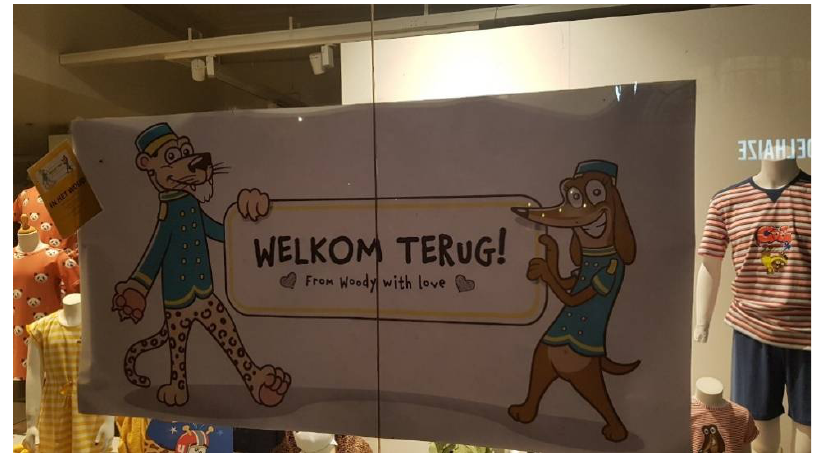
Figure 16. Welcome back! From Woody with love.